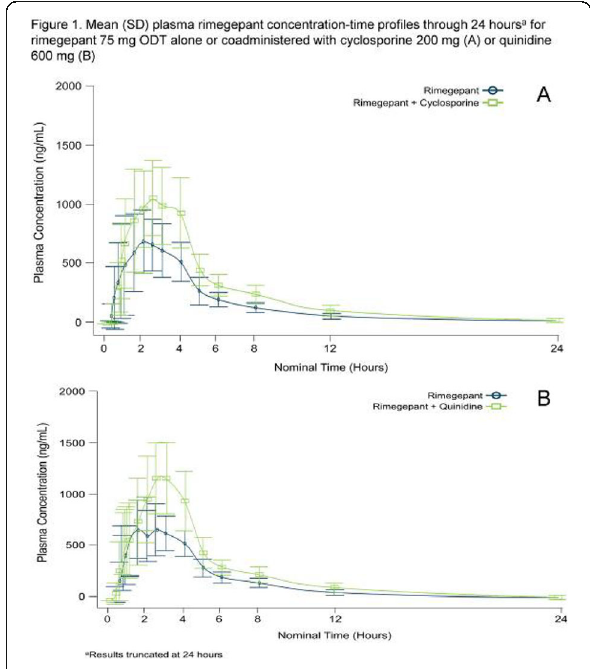
Fig. 1 (abstract P0458). See text for